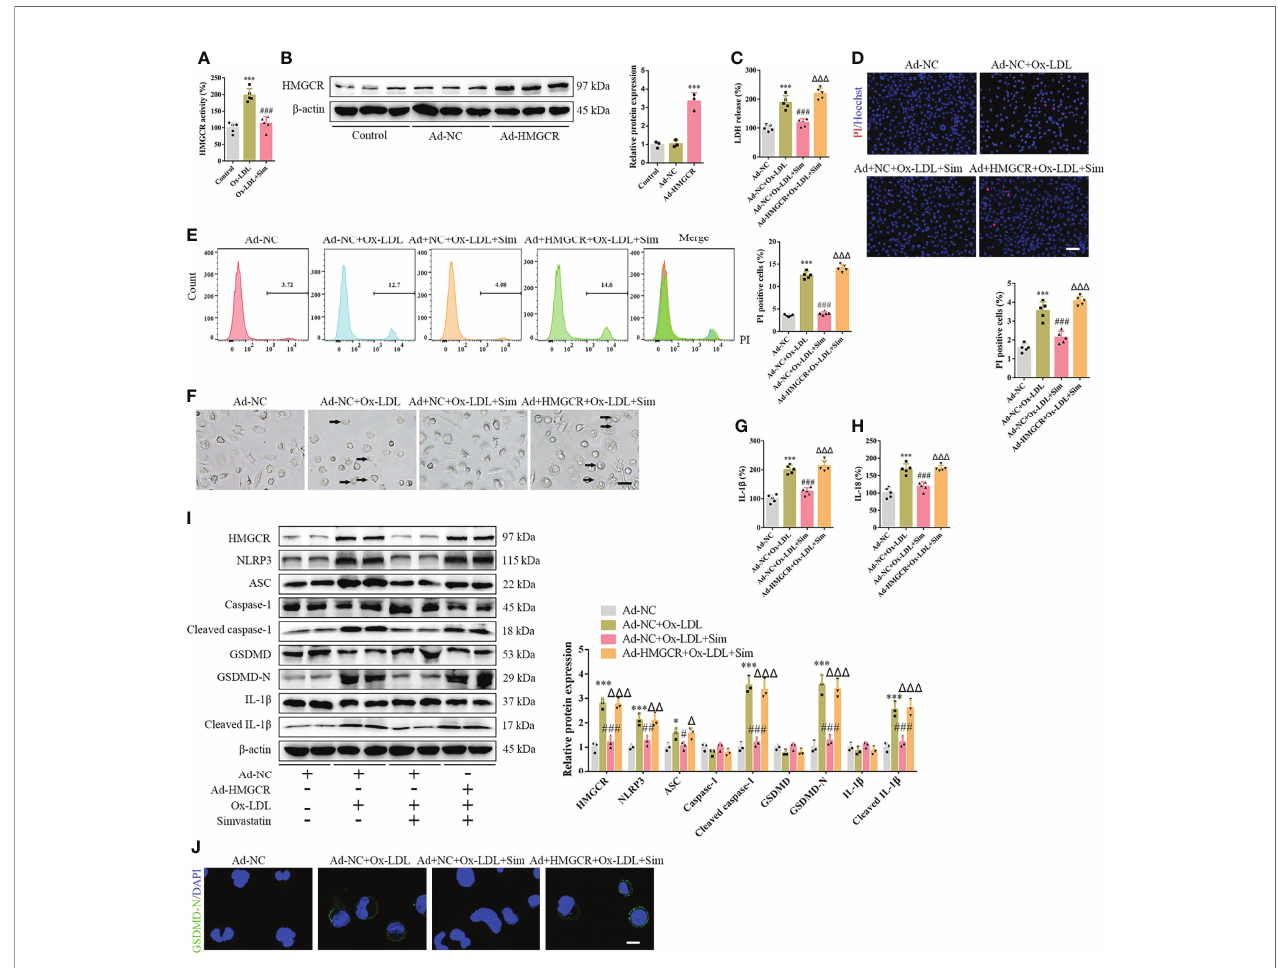
FIGURE 4 | HMGCR overexpression reverses the effects of simvastatin on foam cell pyroptosis. (A) HMGCR activity detection. (B) Western blotting showing HMGCR overexpression. (C) Lactate dehydrogenase release in the cell supernatants. (D) Hoechst 33342 (blue) and propidium iodide (red) fl uorescence staining showing cell membrane integrity. Scale bar, 100 m m. (E) Flow cytometry to detect pyroptotic cells. (F) Pyroptotic bubbles (arrow) observed through microscopy. Scale bar, 25 m m. (G, H) Enzyme-linked immunosorbent assay for the detection of IL-1 b and IL-18 levels in the cell supernatants. (I) Western blotting showing protein abundance. (J) Immuno fl uorescence staining showing the GSDMD-N activation. Scale bar, 12.5 m m. *p < 0.05, ***p < 0.001, versus the Ad-NC group. # p < 0.05, ## p < 0.01, ### p < 0.001, versus the Ad-NC + ox-LDL group. △ p < 0.05, △△ p < 0.01, △△△ p < 0.001, versus the Ad-NC + ox-LDL + sim